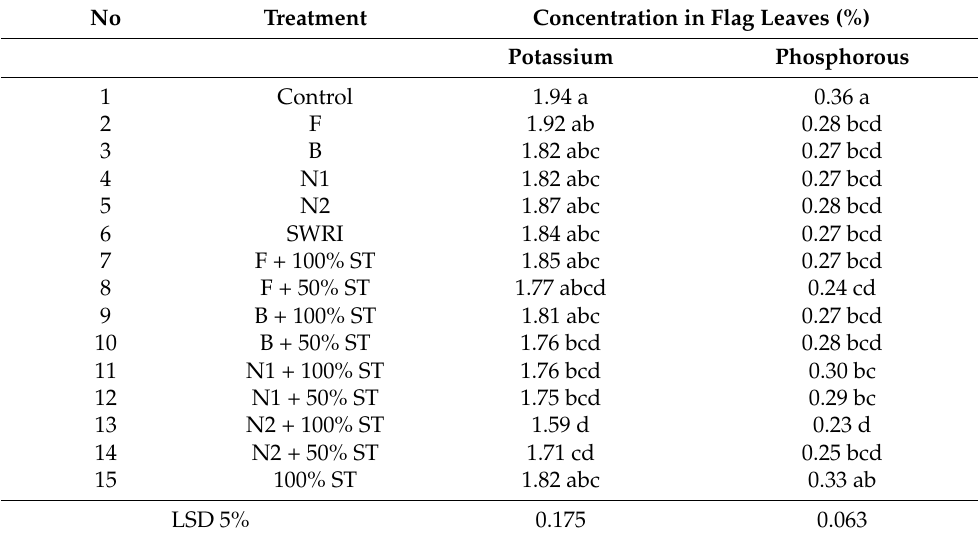
Table 4. Means comparison analysis of the effect of the applied PGPR and their combinations with soil test need-based N, P, and Zn chemical fertilizers on the potassium and phosphorous contents in the flag leaves of the Azar-2 rainfed wheat cultivar. No Treatment Concentration in Flag Leaves (%)